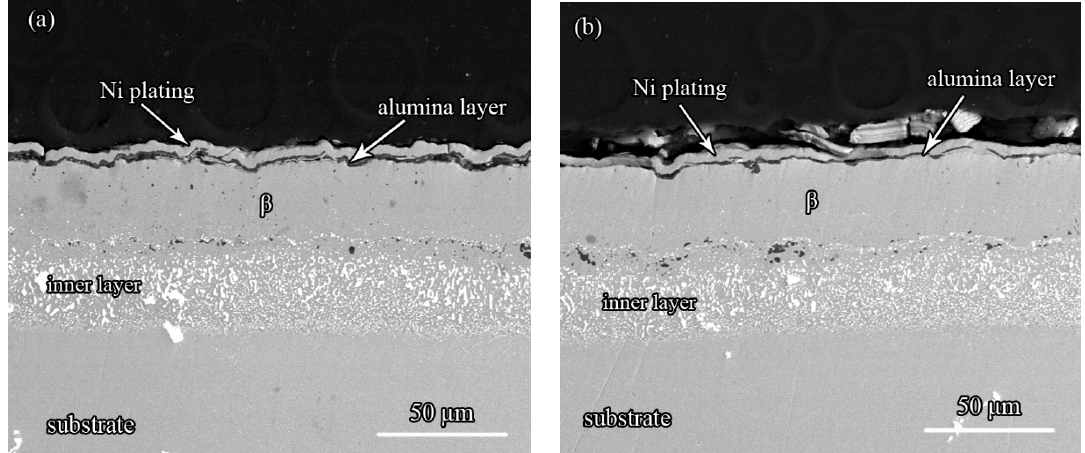
Figure 6. Cross-sectional morphologies of the coatings after oxidation at 1100 °C for 2 h: ( a ) PtAl and ( b ) PtSiAl.